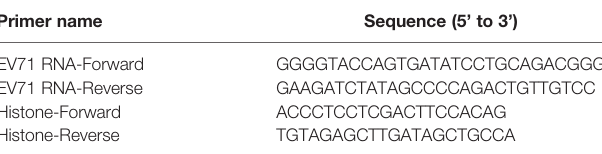
TABLE 2 | The sequences of PCR primer